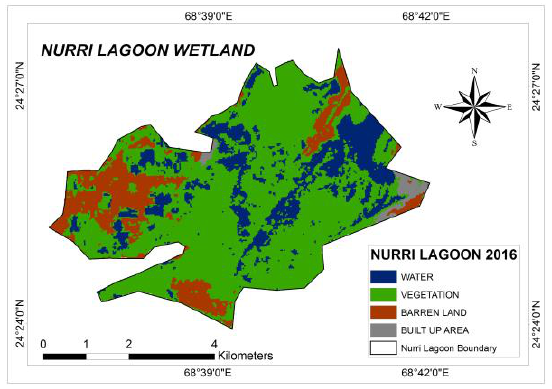
Figure 9: Landcover classification map of Nurri Lagoon 2006 There is significant amount of water seen during 2006 but there is considerable decrease in area of wetland water.